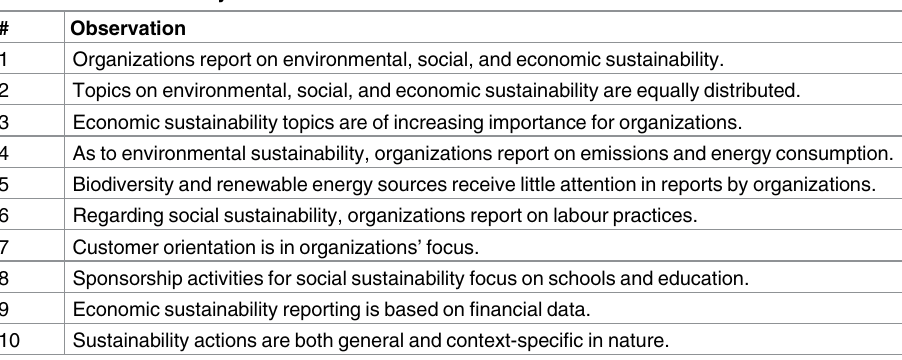
Table 2. Results of